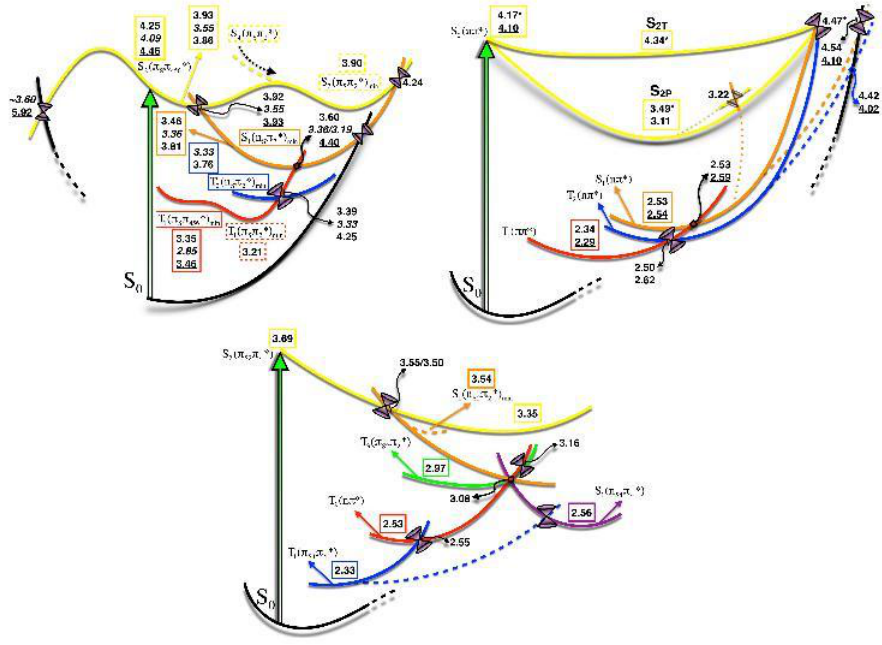
Figure 4. Potential Energy Profiles for 2t-Ura ( Top left ) and 4t-Thy ( Top right ) and 2,4-dtThy ( Bottom ) inferred from quantum mechanical studies. Energies in eV relative to the ground state. For 2t-Ura, underlined energies were extracted from Ref. [90], italic from Ref. [91] and the rest from Ref. [89]. For 4t-Thy, underlined energies were taken from Ref. [95] and the rest were extracted from Ref. [83]. The energies signaled with an asterisk denote geometries optimized including seven water molecules. For 2,4-dtThy, energies were taken from Ref. [96].